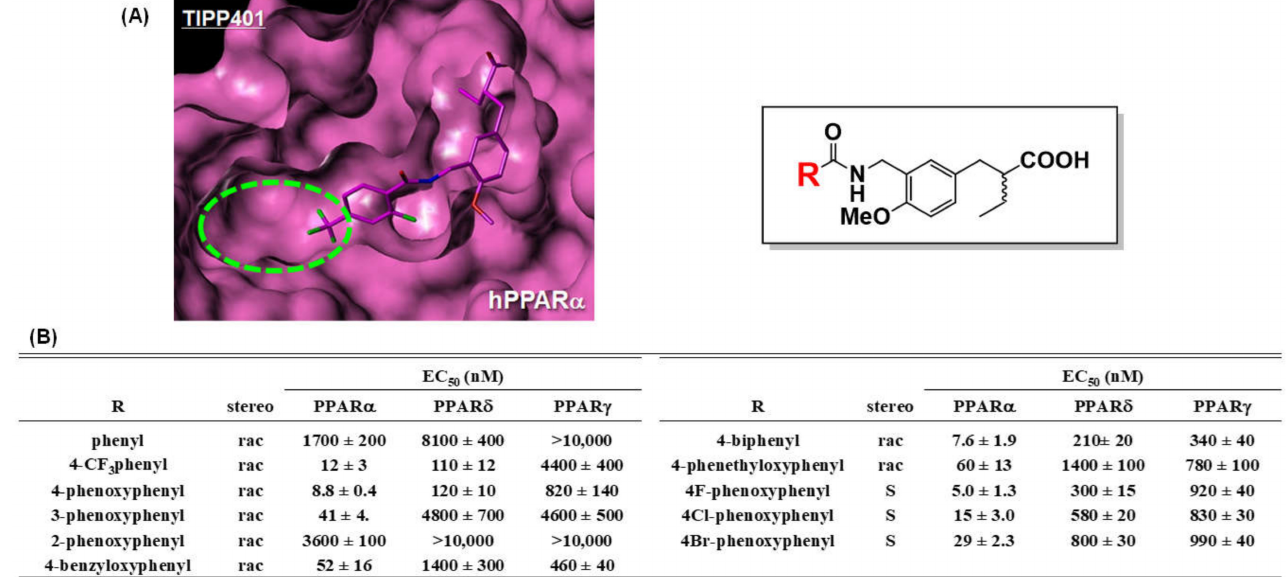
Figure 4. ( A ) Molecular modeling structure of TIPP-401 bound to the hPPAR α LBD. The binding pocket surrounding the hydrophobic tail is indicated by a light green dotted circle. ( B ) Transactivation activity of a series of our